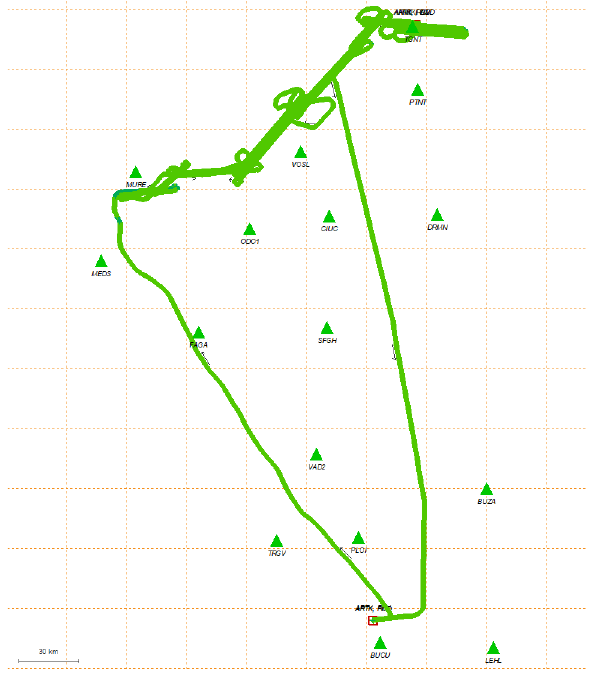
Figure 7 . Post-processing trajectory mission with Novatel Inertial Explorer – from take-off to landing